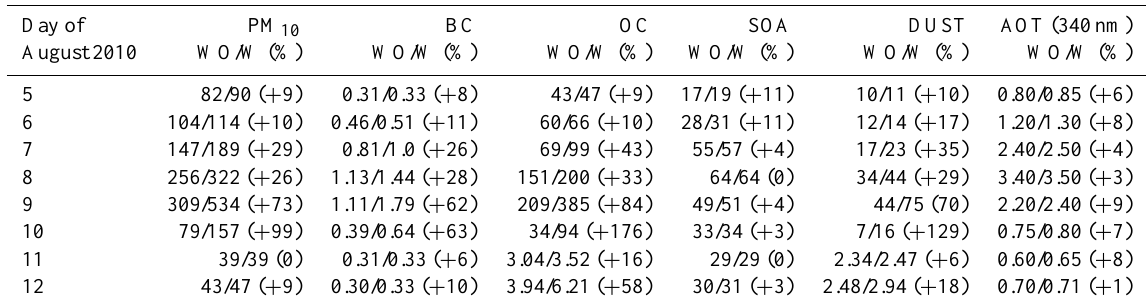
Table 4. Averaged near-surface concentrations (in µgm − 3 ) of PM 10 , BC, OC, SOA and dust along with AOT (340nm) modelled for Moscow for the period 5–12 August 2010 without (WO) and with (W) the ADRF feedback on the input meteorological fields. Percentage changes between the two configurations (W minus WO) are indicated in